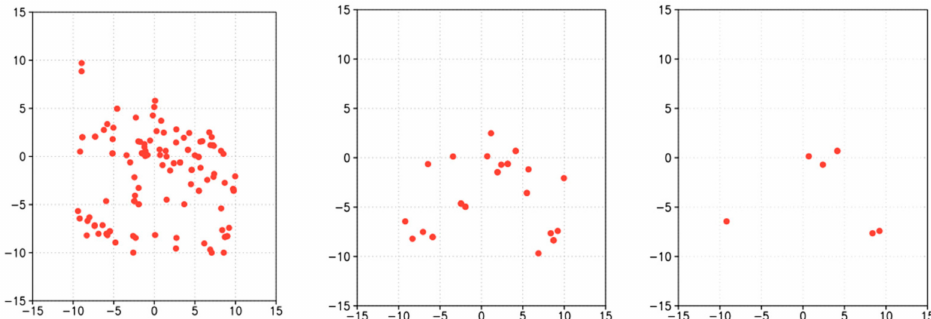
Figure 3. Composite map showing the tornado locations for ( left ) all, ( middle ) enhanced Fujita category (EF)1+, and ( right ) EF2+ tornadoes with respect to the cyclone center (located in the middle of each panel). The cyclone-relative position is in degrees.